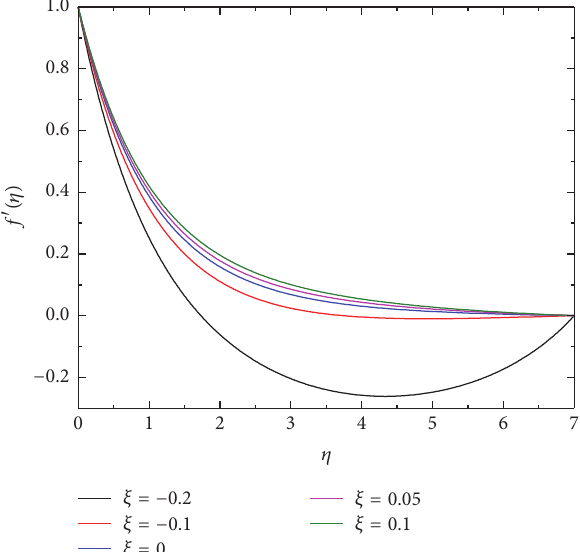
Figure 12: Velocity profiles for various values of 𝜉 when 𝐴 = 0.2 , 𝑅 = 0.5 , and 𝐾 = 0.2 .